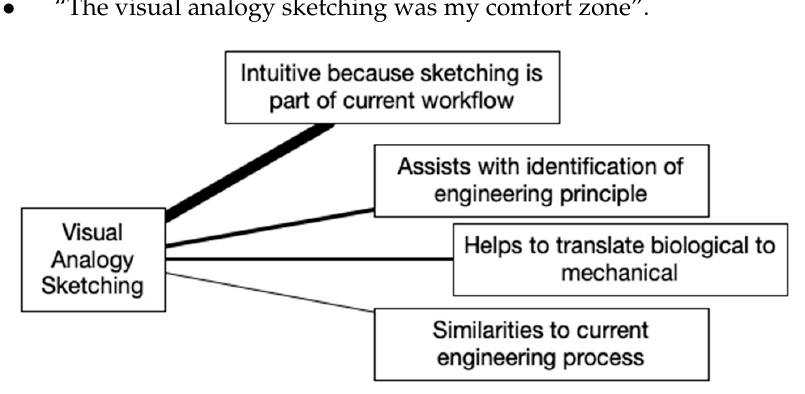
Figure 4. Visual Analogy Sketching discussion